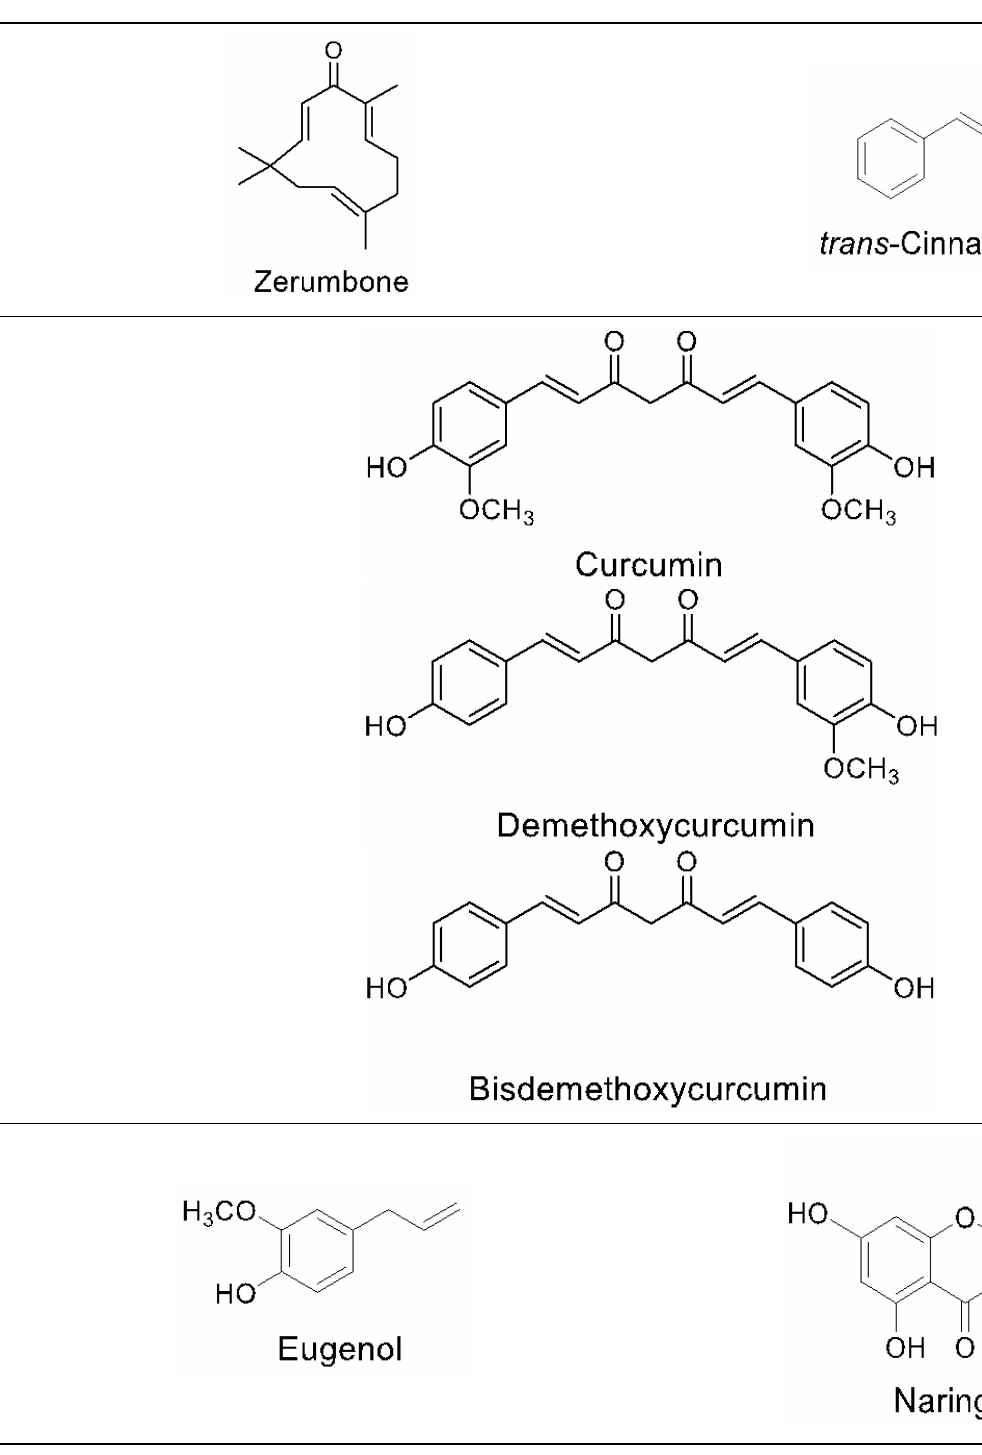
Table 2. Chemical structures of functional food